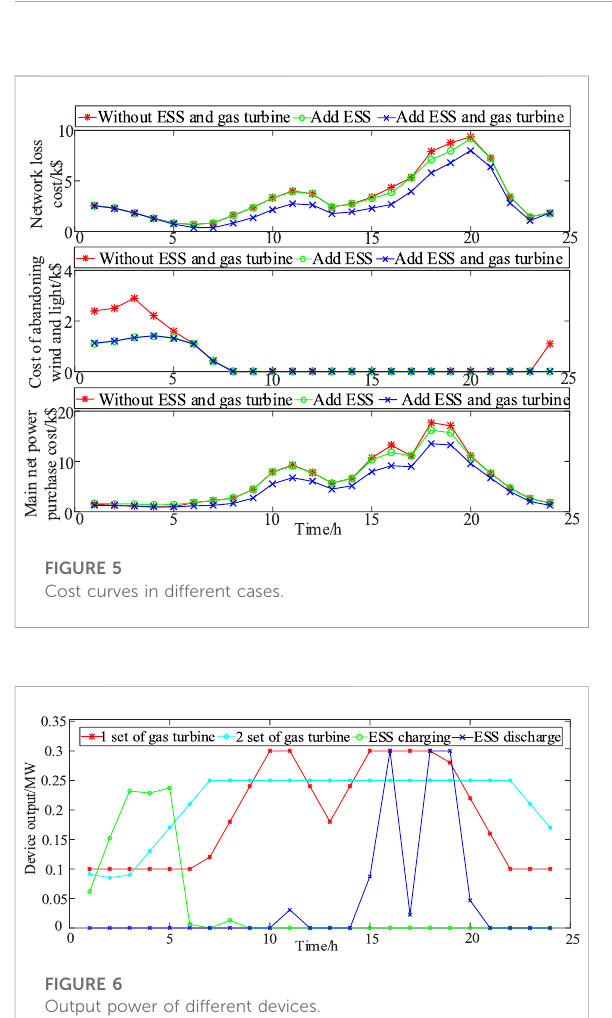
FIGURE 6 Output power of different devices.